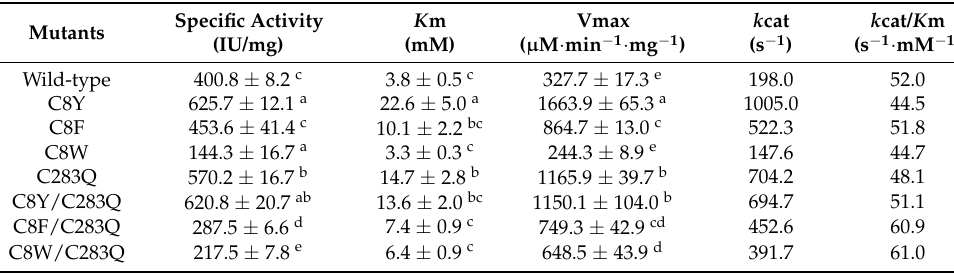
Table 3. Specific activities and kinetic parameters of AsA and its mutants.